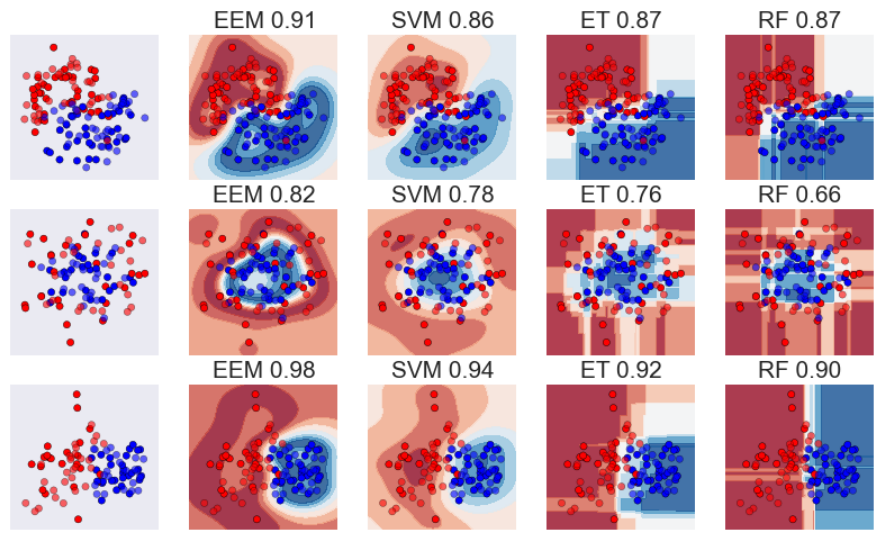
Figure 1. Comparison of the classification of simple 2D datasets with all models used. The number above a particular picture denotes the generalization